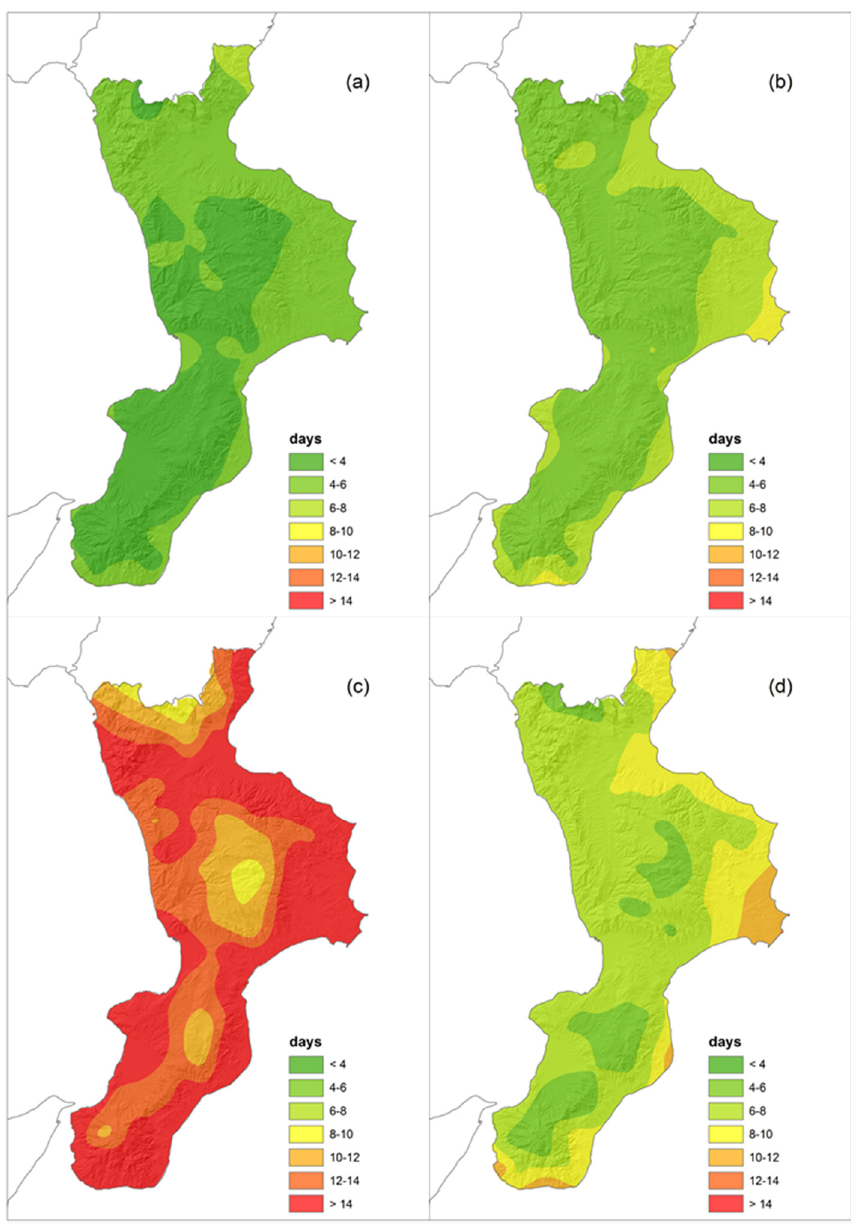
Figure 4. Mean length of the dry spells on a seasonal basis, ( a ) winter; ( b ) spring; ( c ) summer and ( d )